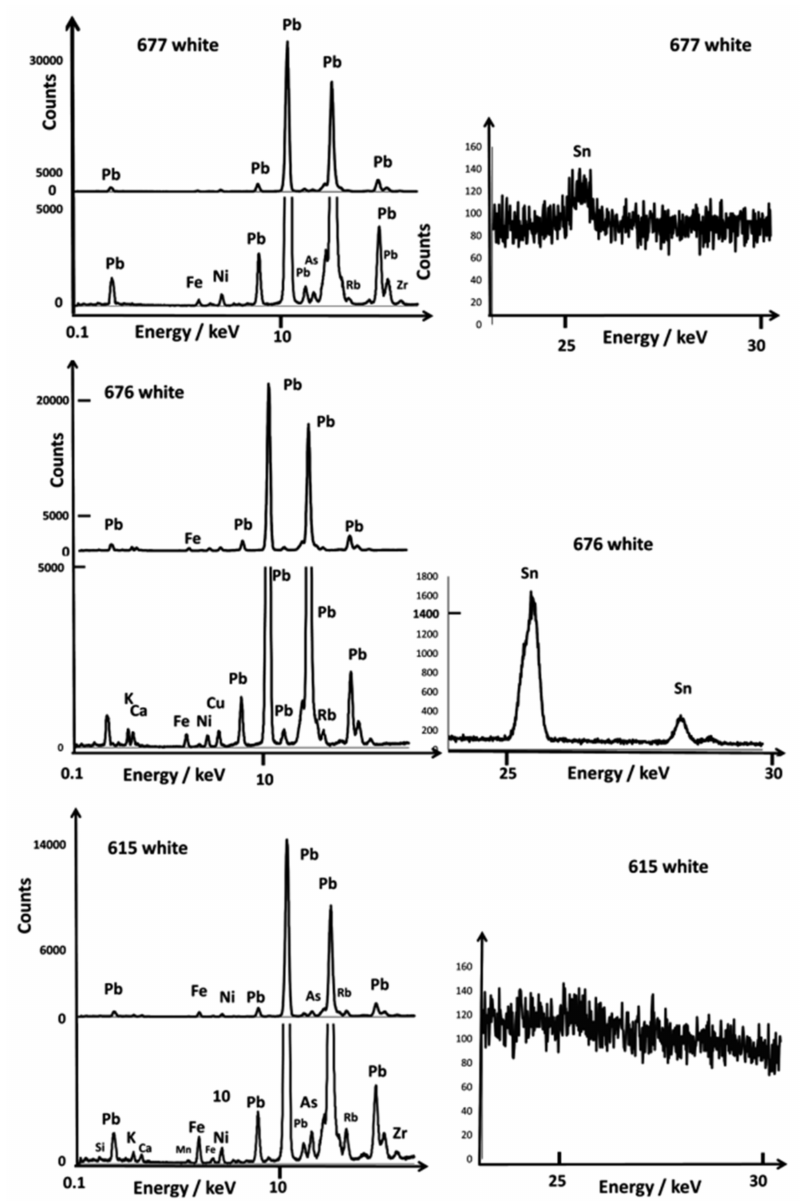
Figure 7. Comparison of representative XRF spectra for white painted decor in the 0.1–20 and 20–30 keV energy